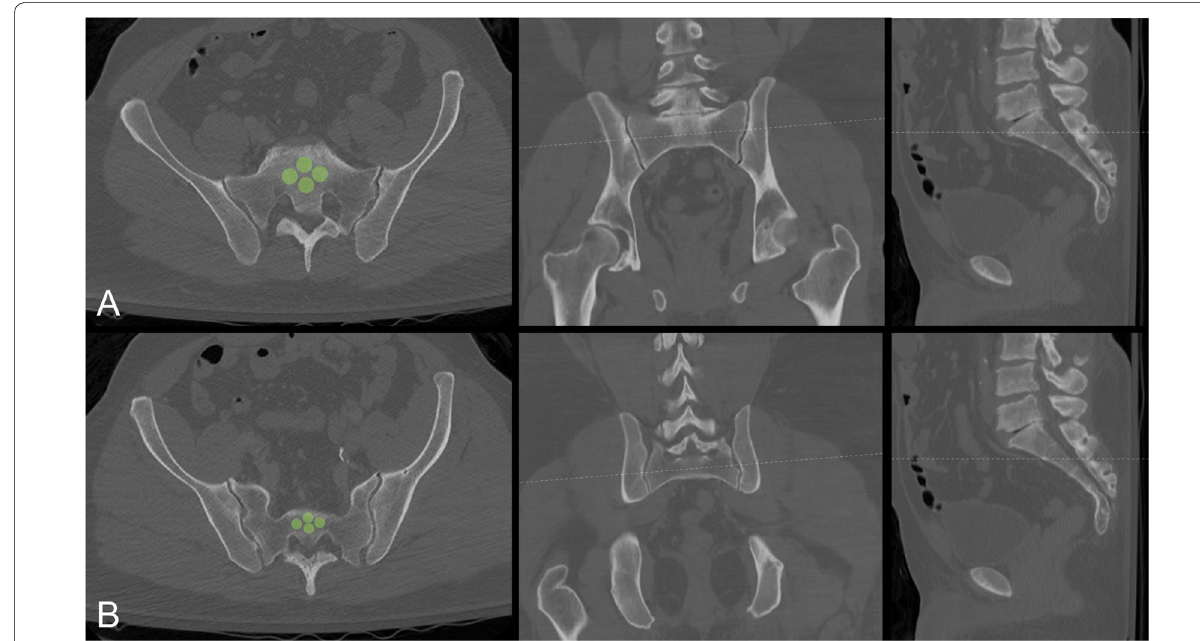
Fig. 2 Axial, sagittal, and coronal CT images depicting cross-referencing technique used for localization of regions of interest (ROIs) represented by green circles in ( a ) S1 and ( b )